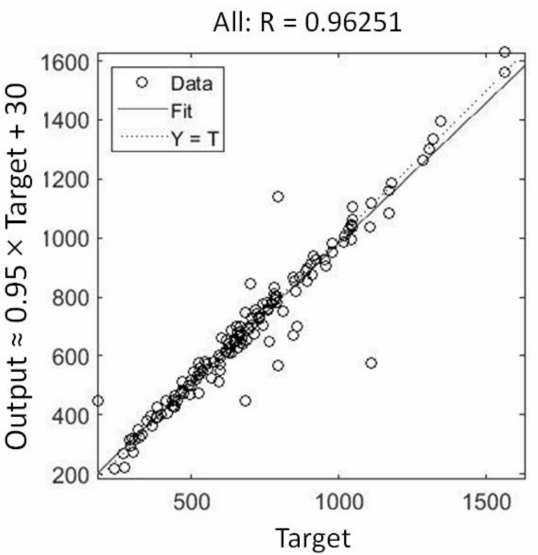
Figure 9. Regression of data of the whole dataset for the ANN fitting function with 20